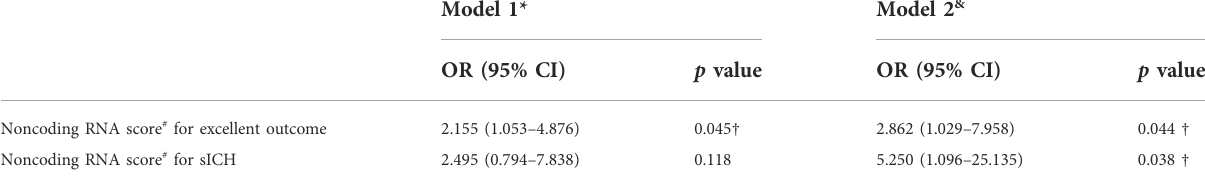
TABLE 2 Noncoding RNA score and the risk of the outcomes after rtPA treatment (n = 103).